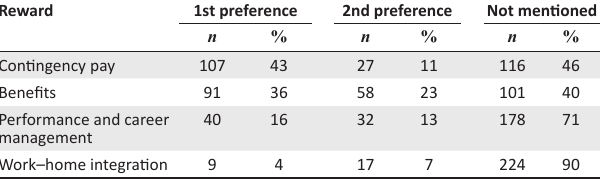
Quality work environment by gender